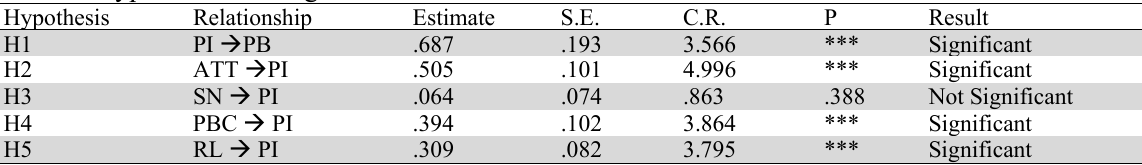
Result of Hypotheses